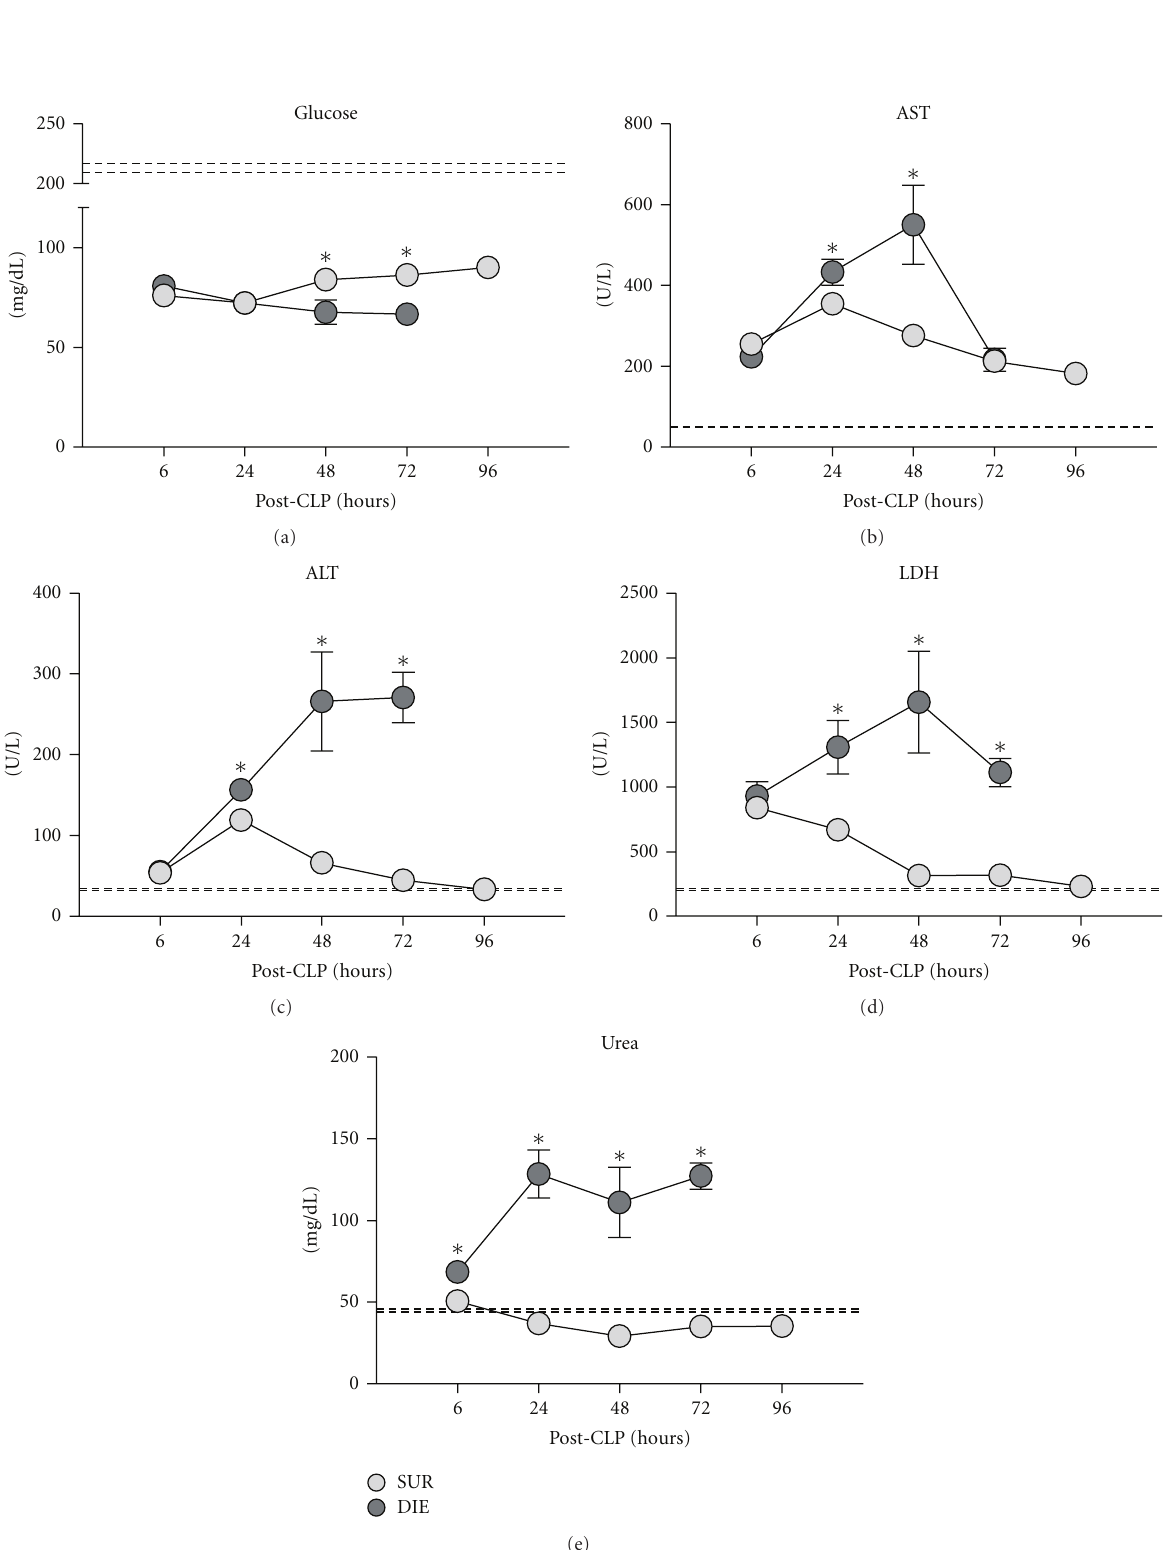
Figure 8: Retrospective comparison of circulating glucose, AST, ALT, LDH, and urea in dying (DIE) versus surviving (SUR) animals after- CLP. 3-month-old female mice were subjected to trauma/hemorrhage followed by polymicrobial CLP-induced sepsis. Displayed values were compared between DIE and SUR groups 6h (DIE n = 23, SUR n = 32; AST: DIE n = 8, SUR n = 20), 24h (DIE n = 28, SUR n = 34; AST: DIE n = 14, SUR n = 23), 48 h (DIE n = 19, SUR n = 34; AST: DIE n = 9, SUR n = 23), 72h (DIE n = 12, SUR n = 34; AST: DIE n = 3, SUR n = 23), and 96 h (SUR at least n = 33; AST: SUR n = 23) after-CLP. Dotted lines represent normal values. ∗ P < .